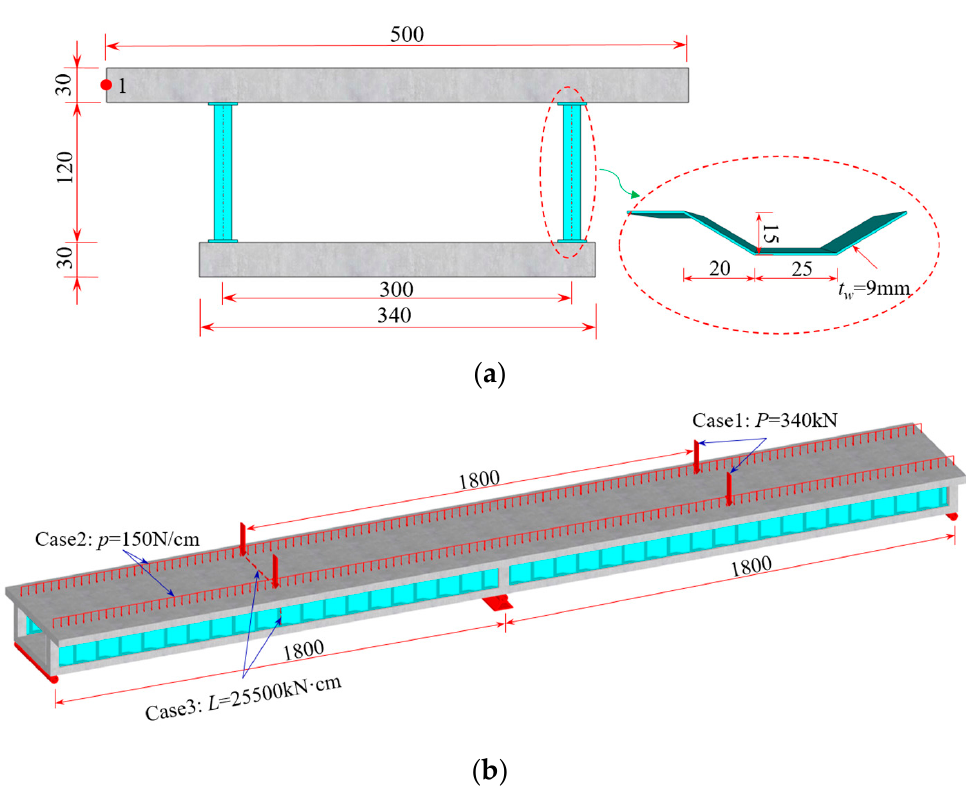
Figure 8. Two span continuous CBG-CSWs (unit: cm): ( a ) cross-section; ( b ) load